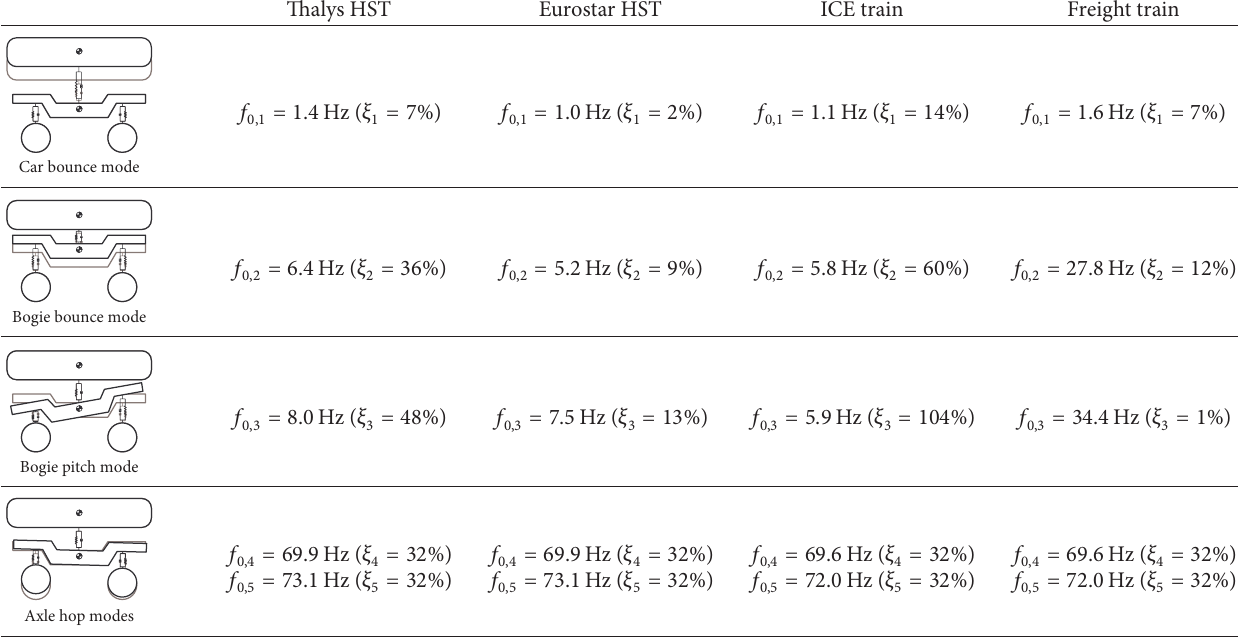
Table 2: Mode shapes of the studied trains (coupled with the track).